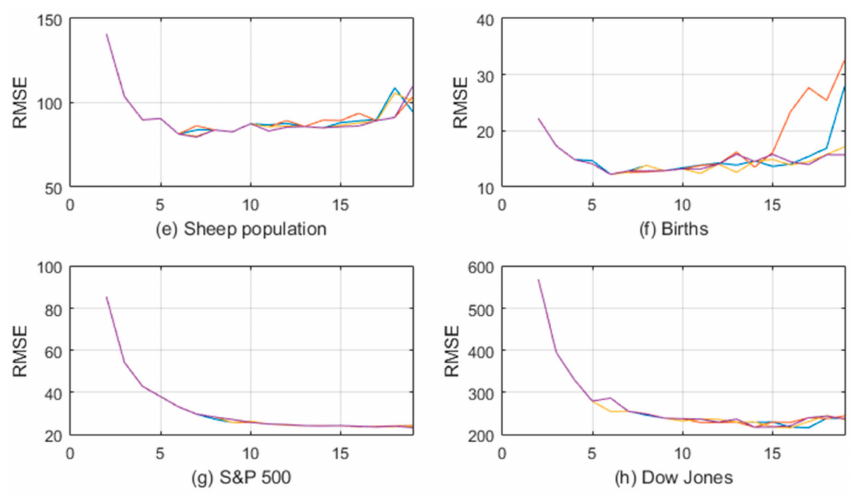
Figure 6. The performance of the fuzzy cognitive map (FCM) model with different